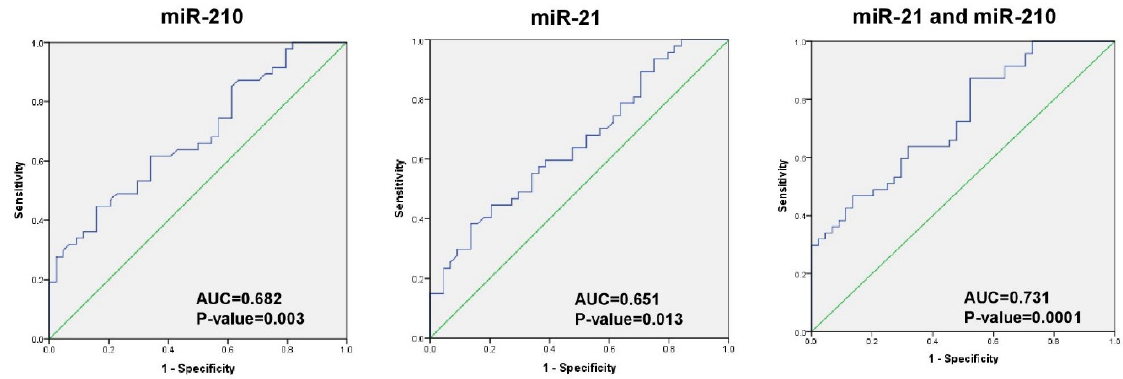
Figure 3. Receiver Operating Characteristics (ROC) curve of miR-210, miR-21 and their combination to differentiate CRC patients from healthy subjects. Table 2. Diagnostic parameters to evaluate individual and combined miRNA for diagnosis of CRC patients. AUC: area under the curve, SE: standard error of mean, PPV: positive predicted value, NPV: negative predicted value, and DA: diagnostic accuracy. miRNA